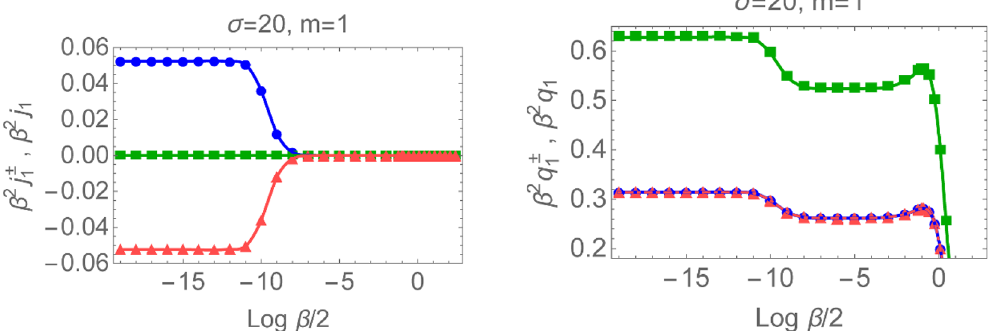
Figure 2 . Left: the total scaled energy current (cid:12) 2 j (triangles, red) and (cid:12) 2 j (cid:0) green), the contribution (cid:12) 2 q + m =